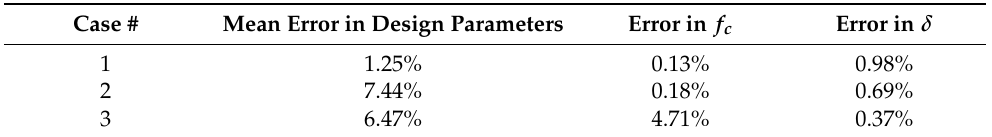
Table 1. Errors of the DNN predictions for the three case studies discussed in Section 4.2. For the error in the design parameters, the normalized mean absolute error evaluated using Equation (7) was used. Normalized absolute errors were used for the band gap ( f c and δ ).